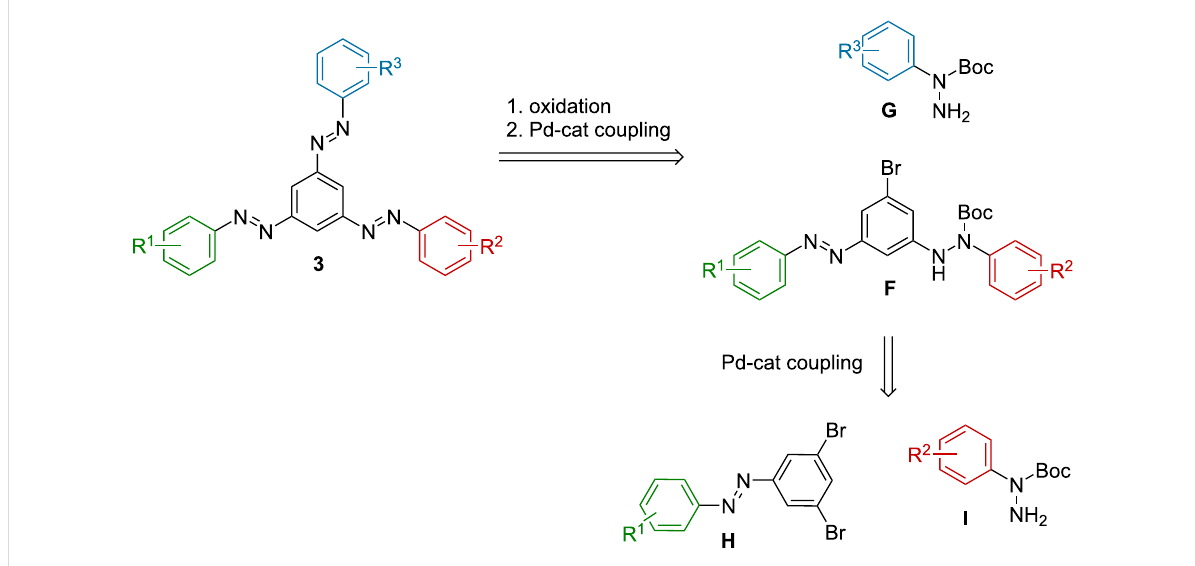
Scheme 2: Preparation of tris(arylazo)benzenes 3 by Pd-catalyzed cross-coupling reactions of N -Boc-arylhydrazides and bromo-substituted ABs, fol- lowed by